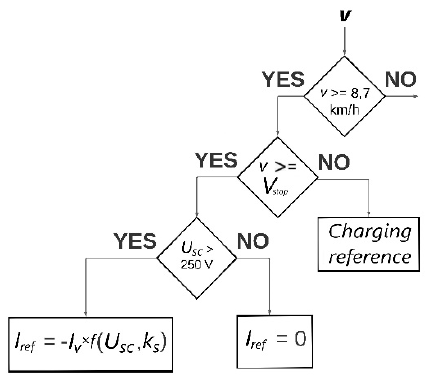
Figure 6. Flow diagram for the medium kinetic energy zone.